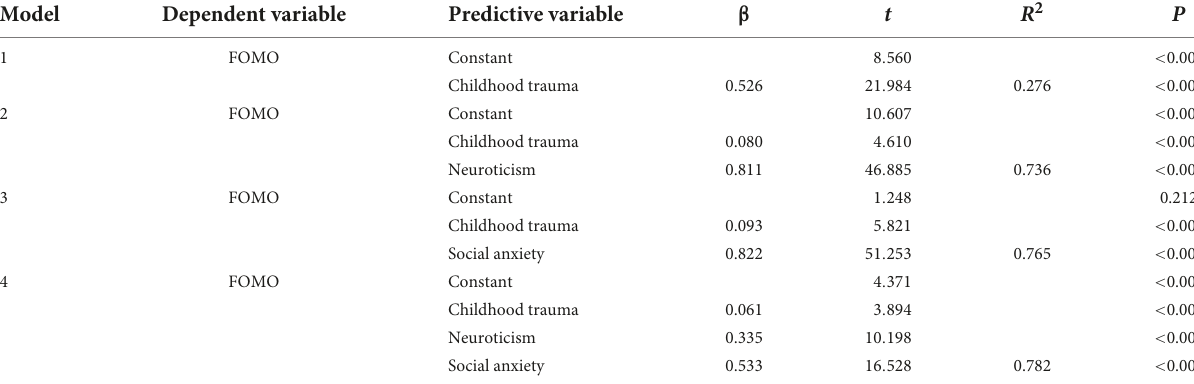
TABLE 2 Results of stepwise regression analysis.